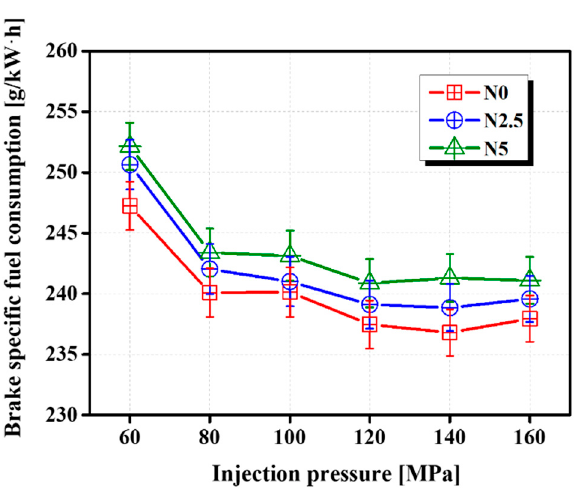
Figure 7. Curve analysis of brake specific fuel consumption according to injection pressure for n -octanol/diesel blends.